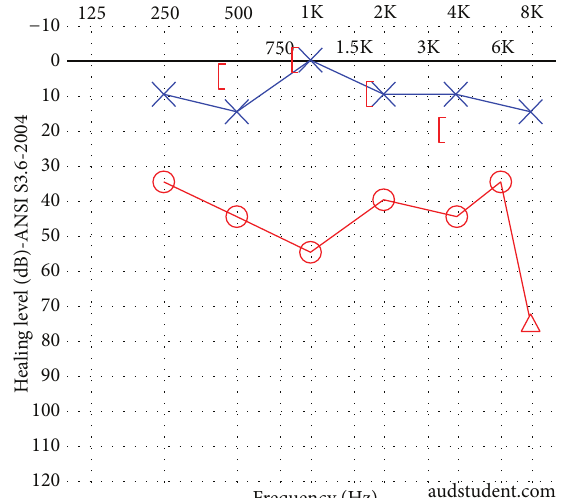
Figure 5: Audiogram of patient in Case 2 following right middle ear exploration. The mixed hearing loss persists, possibly suggesting an uncorrected third window